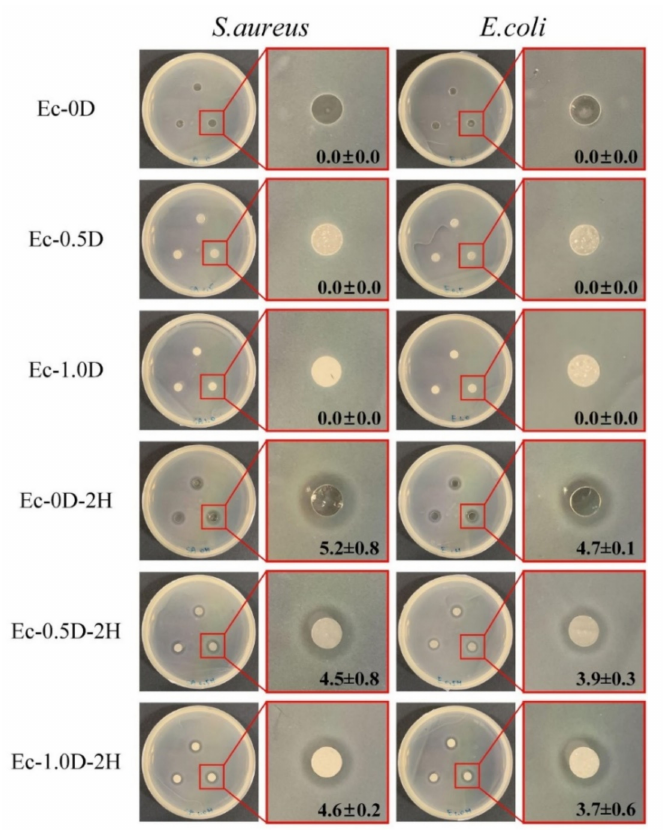
Figure 7. Qualitative images of the antibacterial properties of hydrogel membranes impregnated with different concentrations of hinokitiol for S. aureus and E. coli ( n =